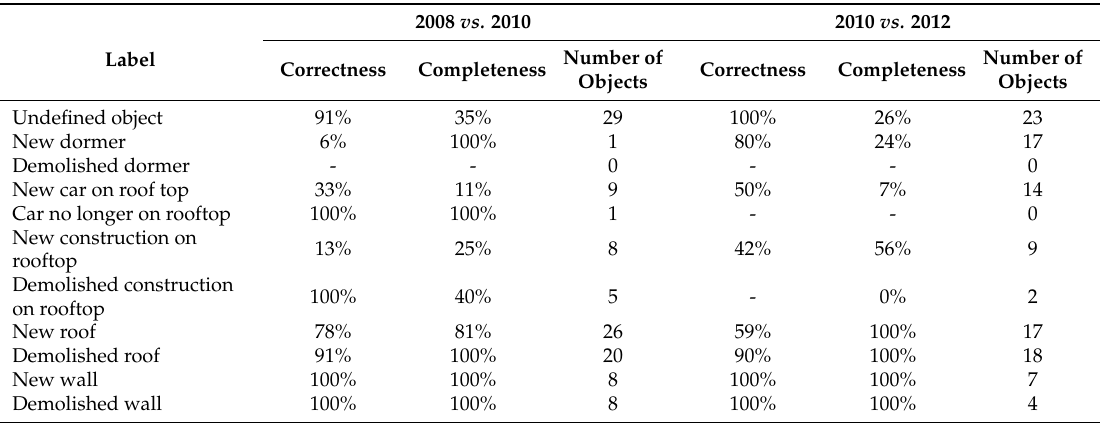
Table 6. Completeness and correctness of the changed objects.